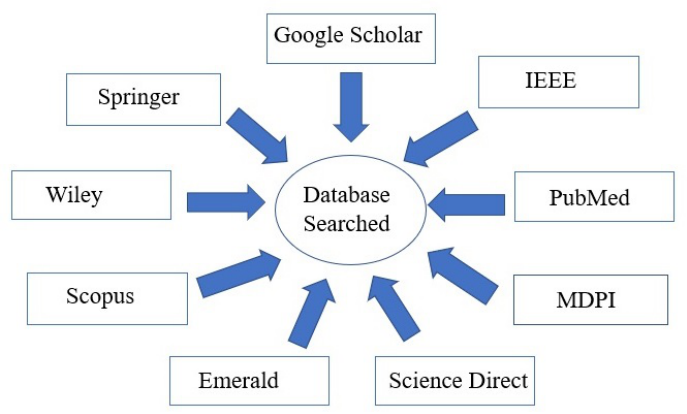
Figure 1. Nine Digital Data